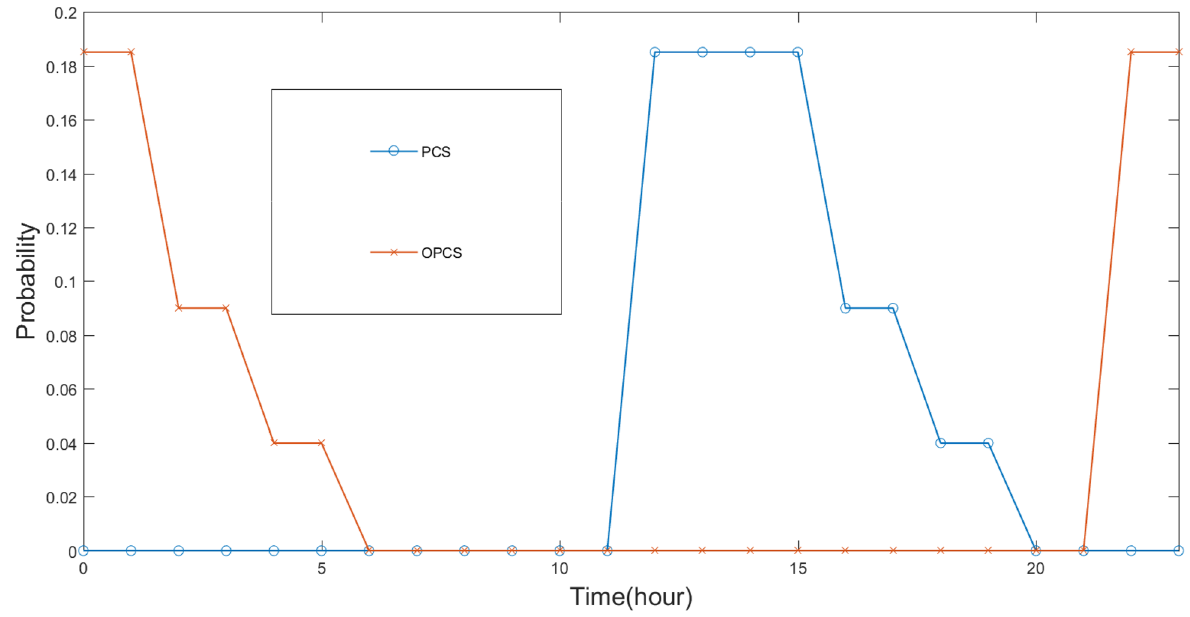
Fig. 1 PEVs probability distribution of PCS and OPCS